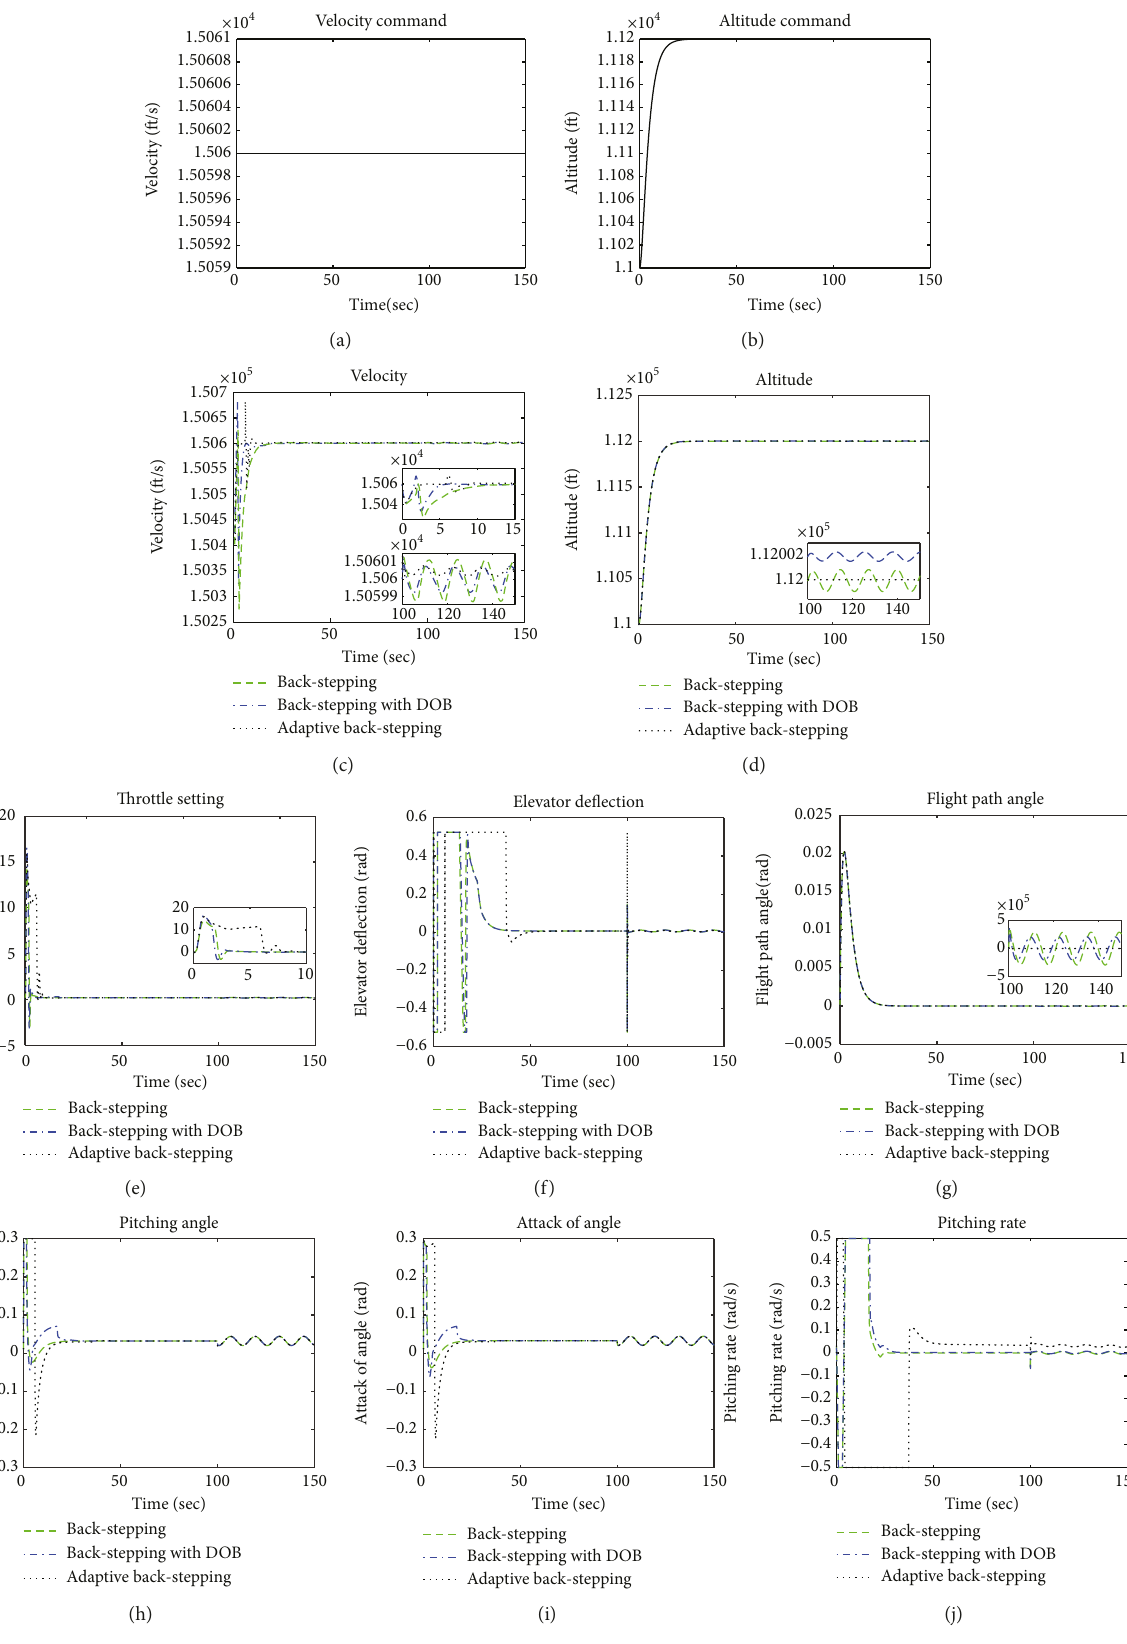
Figure 3: Altitude command, response, and controller. The uncertainty terms and external disturbances are added into the